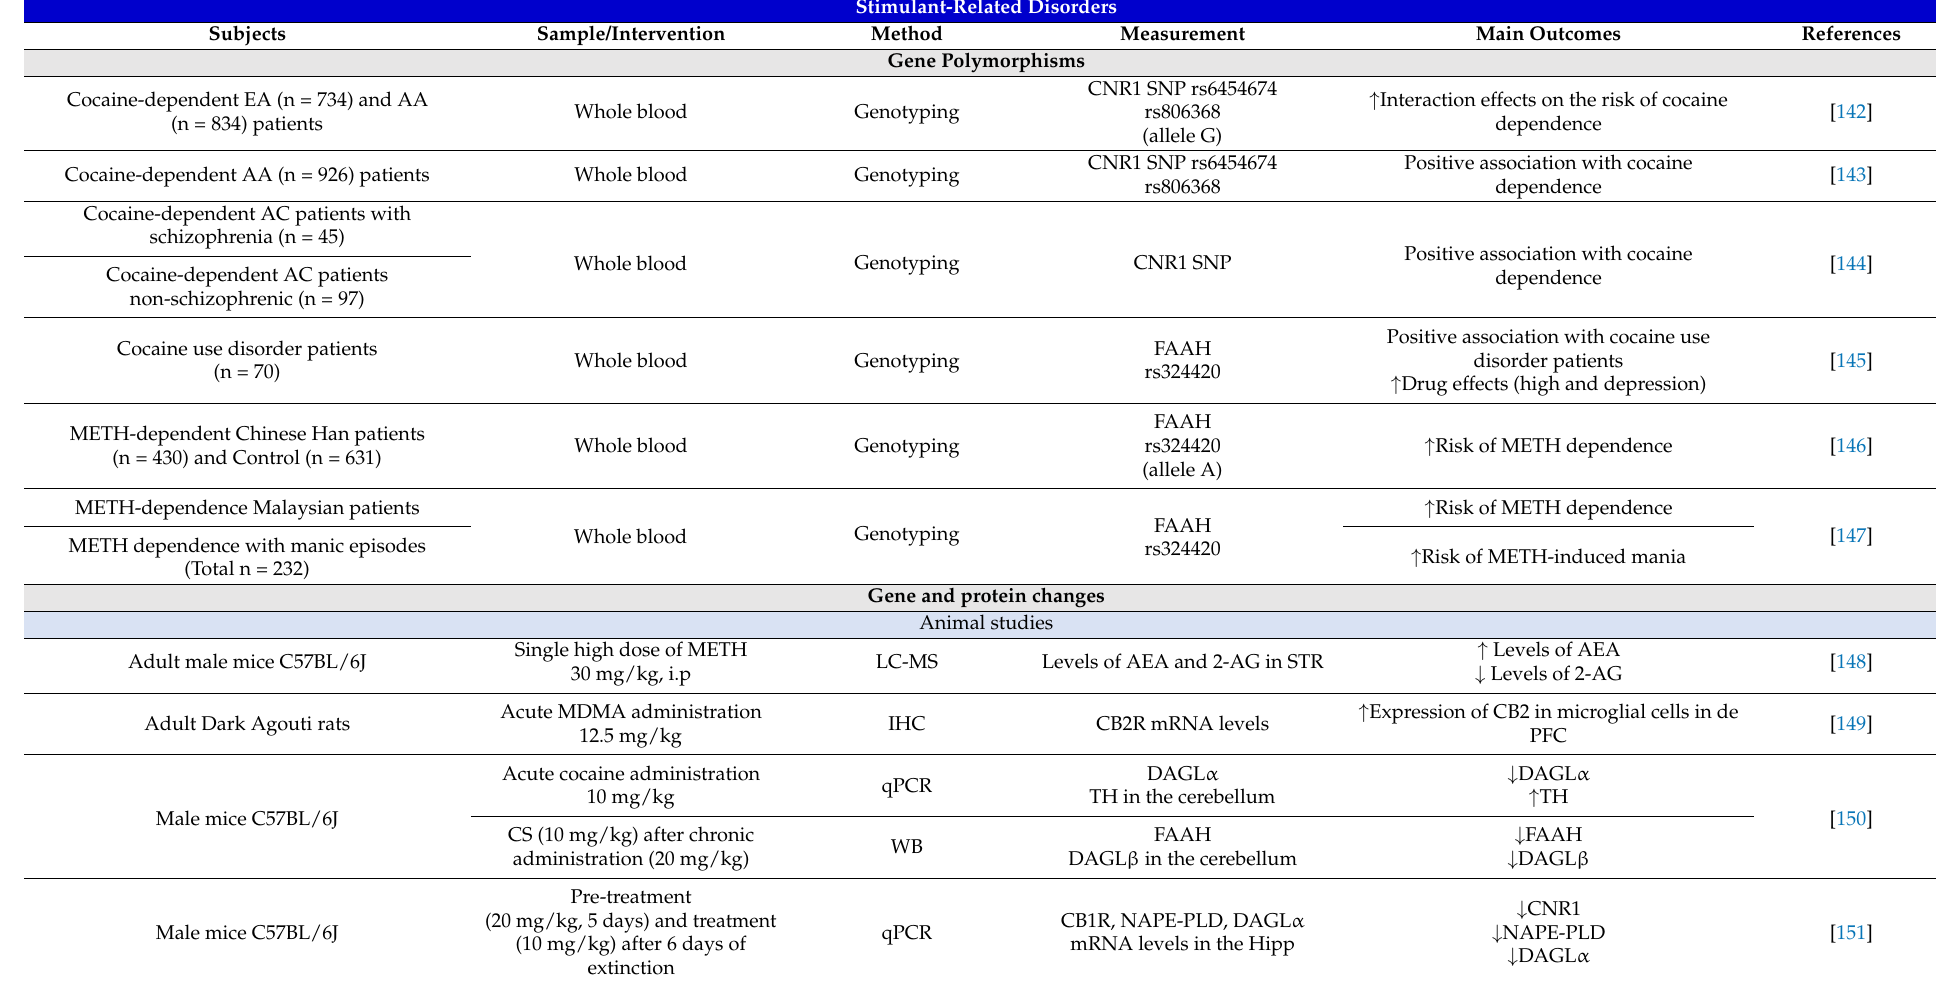
Table 4. Main findings from human and animal studies aimed to identify alterations of ECS components in stimulant-related